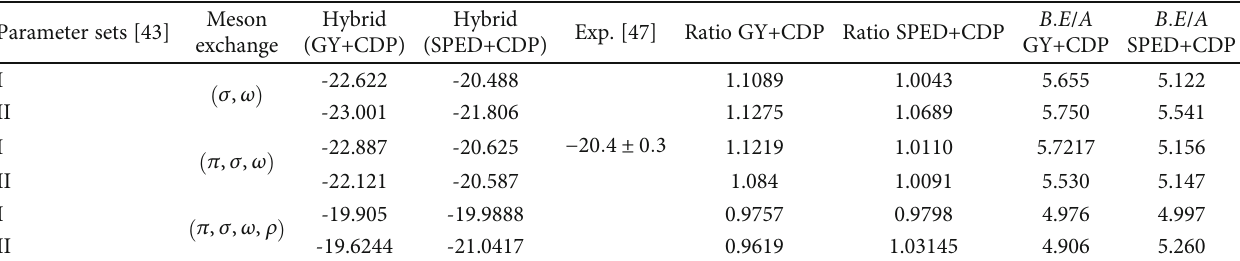
Table 4: The ground-state energy of helium with the hybrid model.